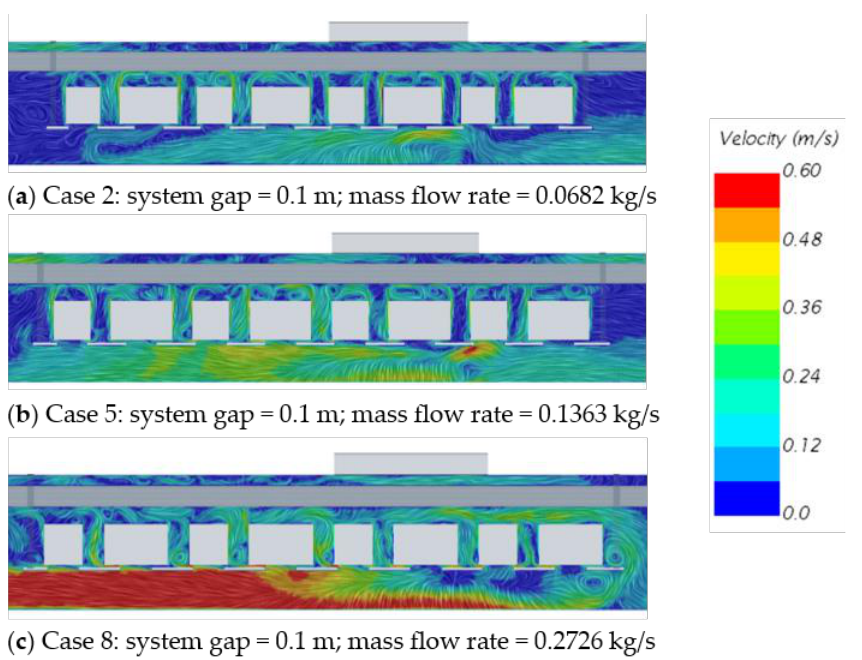
Figure 16. Velocity contours for Cases 2, 5, and 8 of the underfloor equipment bay (Configuration 2) for increasing mass flow rates and a constant system gap.